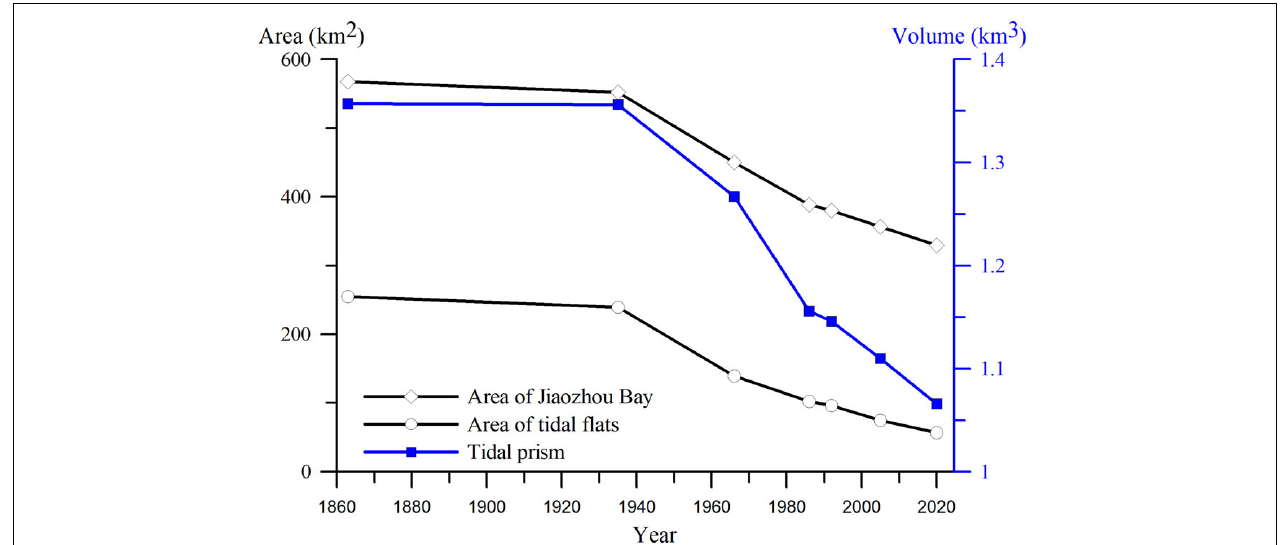
FIGURE 6 | Time series of tidal prism of Jiaozhou Bay, area of Jiaozhou Bay, and area of tidal flats.